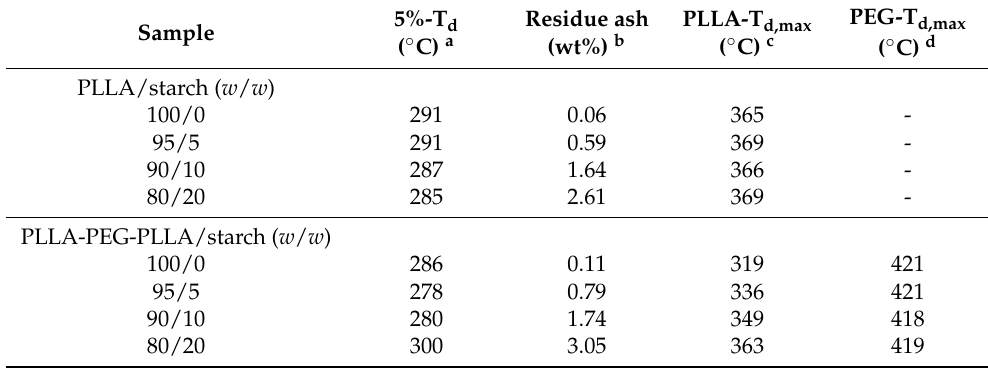
Figure 4. TG and DTG thermograms of native cassava starch. Table 2. Residue ash and temperature of maximum decomposition rate (T d,max ) of the composites.